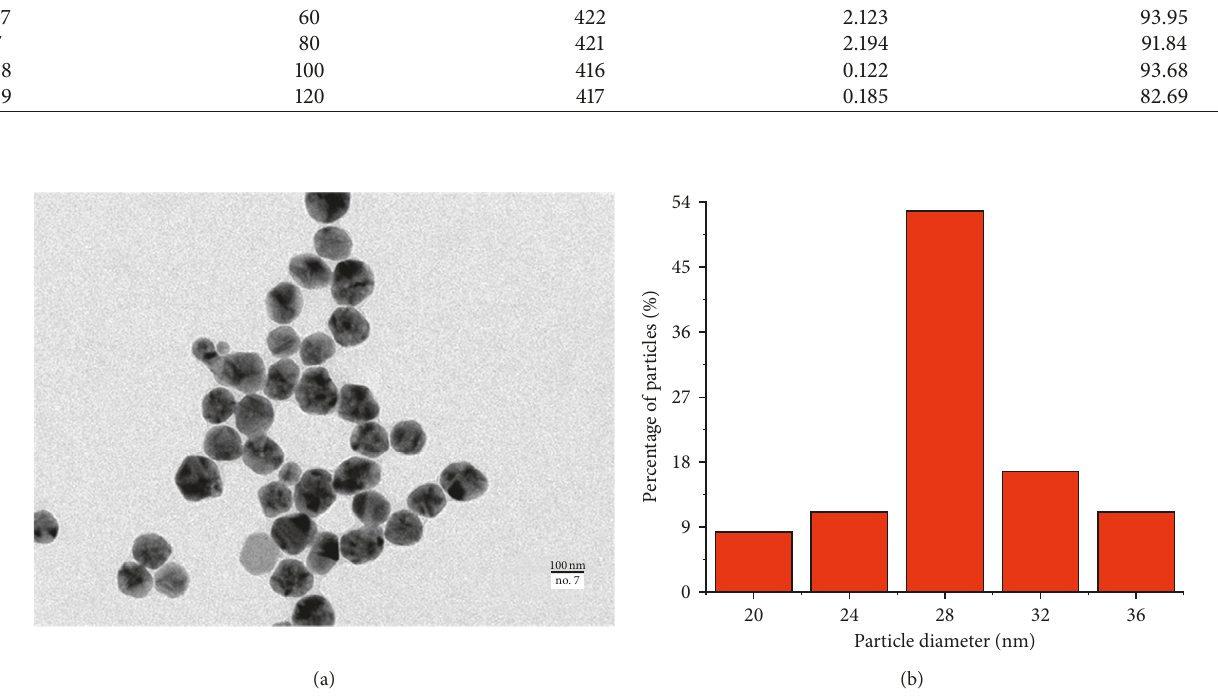
Figure 8: The TEM image (a) and histogram of particle size distribution (b) of synthesized